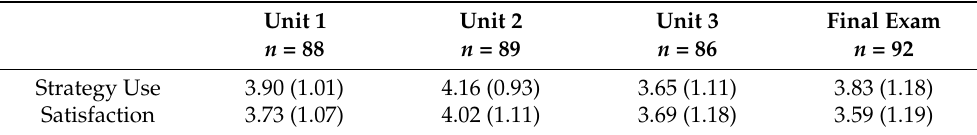
Table 7. Means and Standard Deviation of Strategy Use and Satisfaction Ratings by Exam.